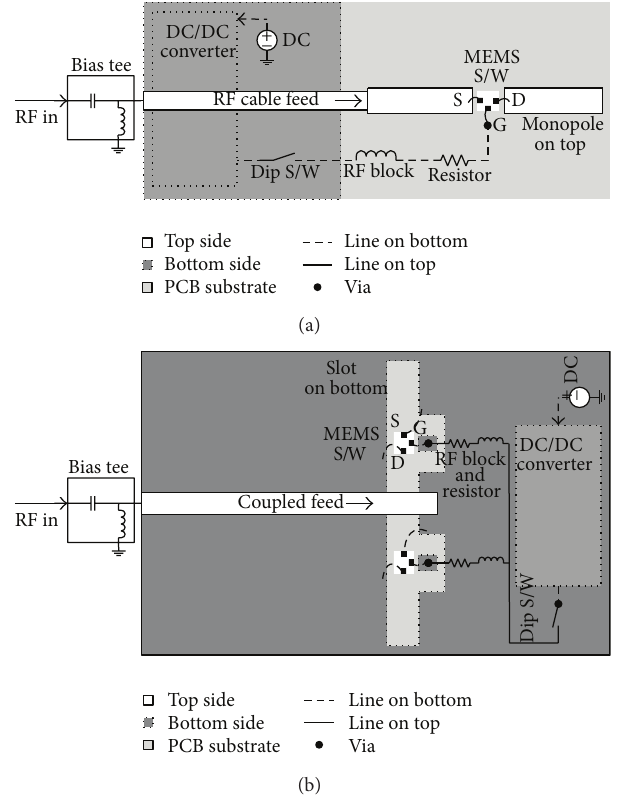
Figure 9: Configurations of reconfigurable antenna with RF-MEMS switches including the biasing network; (a) the monopole antenna and (b) the slot antenna.